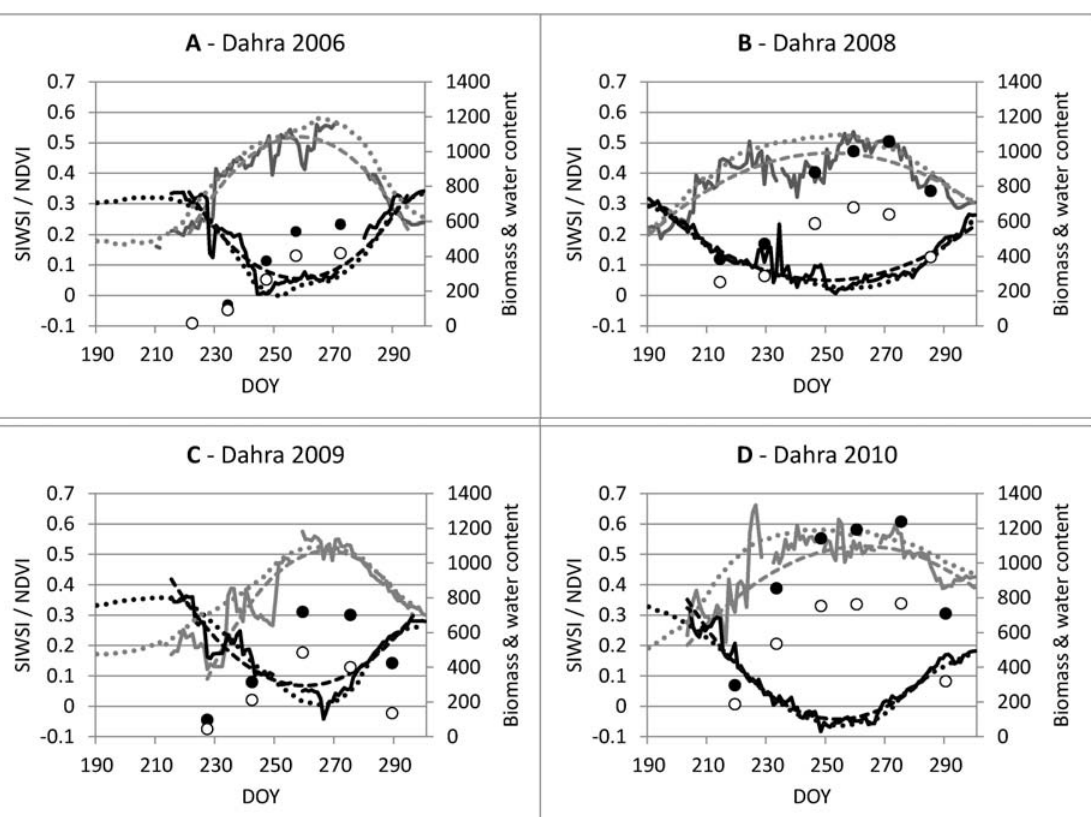
Figure 4. Times series of satellite based Shortwave Infrared Water Stress Index (SIWSI) and Normalized Difference Vegetation Index (NDVI) extracted from the pixels overlapping test sites, including growing season trends described by 2nd order polynomials and Savitsky-Golay smoothing functions, for both SIWSI and NDVI. ( A – D ) show Dahra. ( E , F ) show Agoufou. ( G – I ) show Demokeya. X-axis shows Day of Year. Black lines: Spinning Enhanced Visible and Infrared Imager (SEVIRI) SIWSI, dashed black lines: SIWSI 2nd order trend, dotted black lines: SIWSI Savitsky-Golay trend, grey lines: SEVIRI NDVI, dashed grey lines: NDVI 2nd order trend, dotted grey lines: NDVI Savitsky-Golay trend. Field measurements of fresh biomass (g/m 2 ) shown as solid dots, and vegetation water content (g/m 2 ) shown as hollow